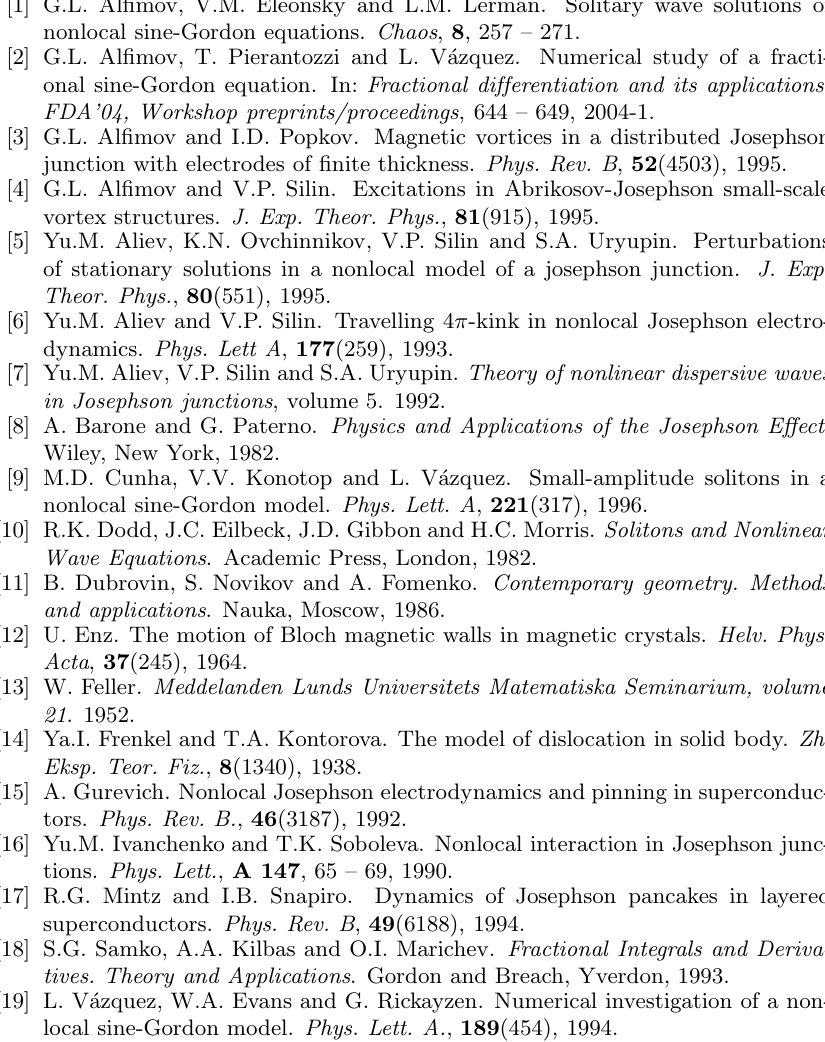
P. Mi(cid:20)skinis nariu. Nustatyti (cid:20)sios lygties ribiniai atvejai, Lagran(cid:20)zianas, simetrijos, tiksl(cid:22)us anali- ziniai sprendiniai. Parodyta, kad (cid:20)sios r(cid:22)u(cid:20)sies nelokali sine -Gordono lygtis turi vieno, dviej(cid:24)u bei N -solitoninius sprendinius, kurie yra atitinkam(cid:24)u klasikini(cid:24)u sine -Gordono lygties sprendini(cid:24)u nelokalios deformacijos. Nelokalios sine -Gordono lygties inte- gruojamumas siejamas su geometrin_emis dvima(cid:20)ci(cid:24)u nelokaliai deformuot(cid:24)u pavir(cid:20)si(cid:24)u